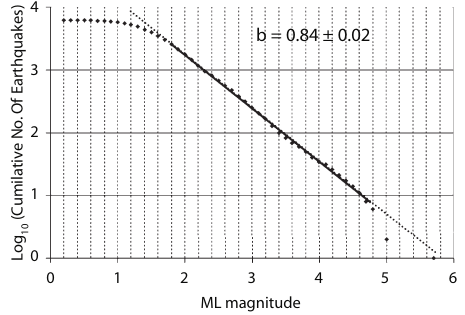
Fig. 4. Cumulated Gutenberg-Richter distribution from the 2006 Italian Seismic